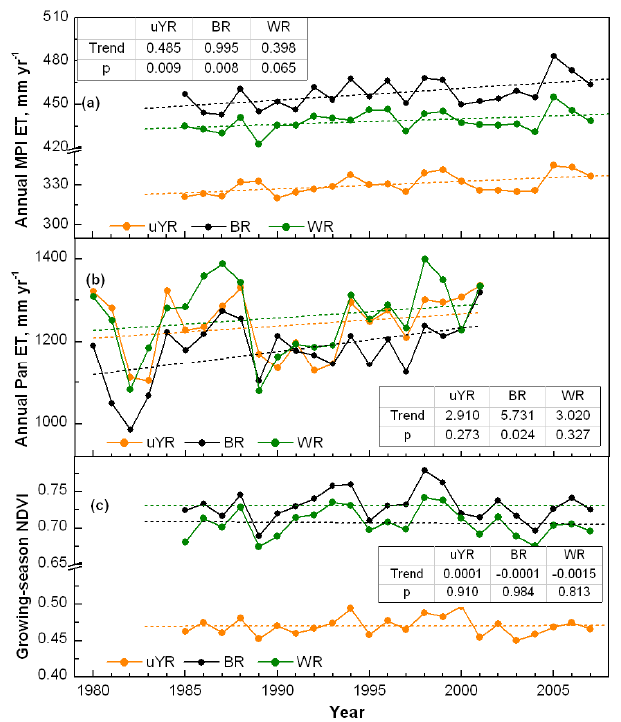
Figure 6. The annual ET ( a , b ) and growing-season Normalized Difference Vegetation Index (NDVI) ( c ) in the BR, WR and uYR basins. ( a ) MPI ET was derived from a global ET dataset upscaled from FLUXNET tower observations [39], while the reference ET ( b ) was obtained from pan evaporation measurements within the study domain. The NDVI record was derived from the GIMMS3g dataset. The trends were calculated for different periods ( i.e. , 1985–2007 in panels ( a ) and ( c ), and 1980–2001 in panel ( b )) due to data availability constraints.